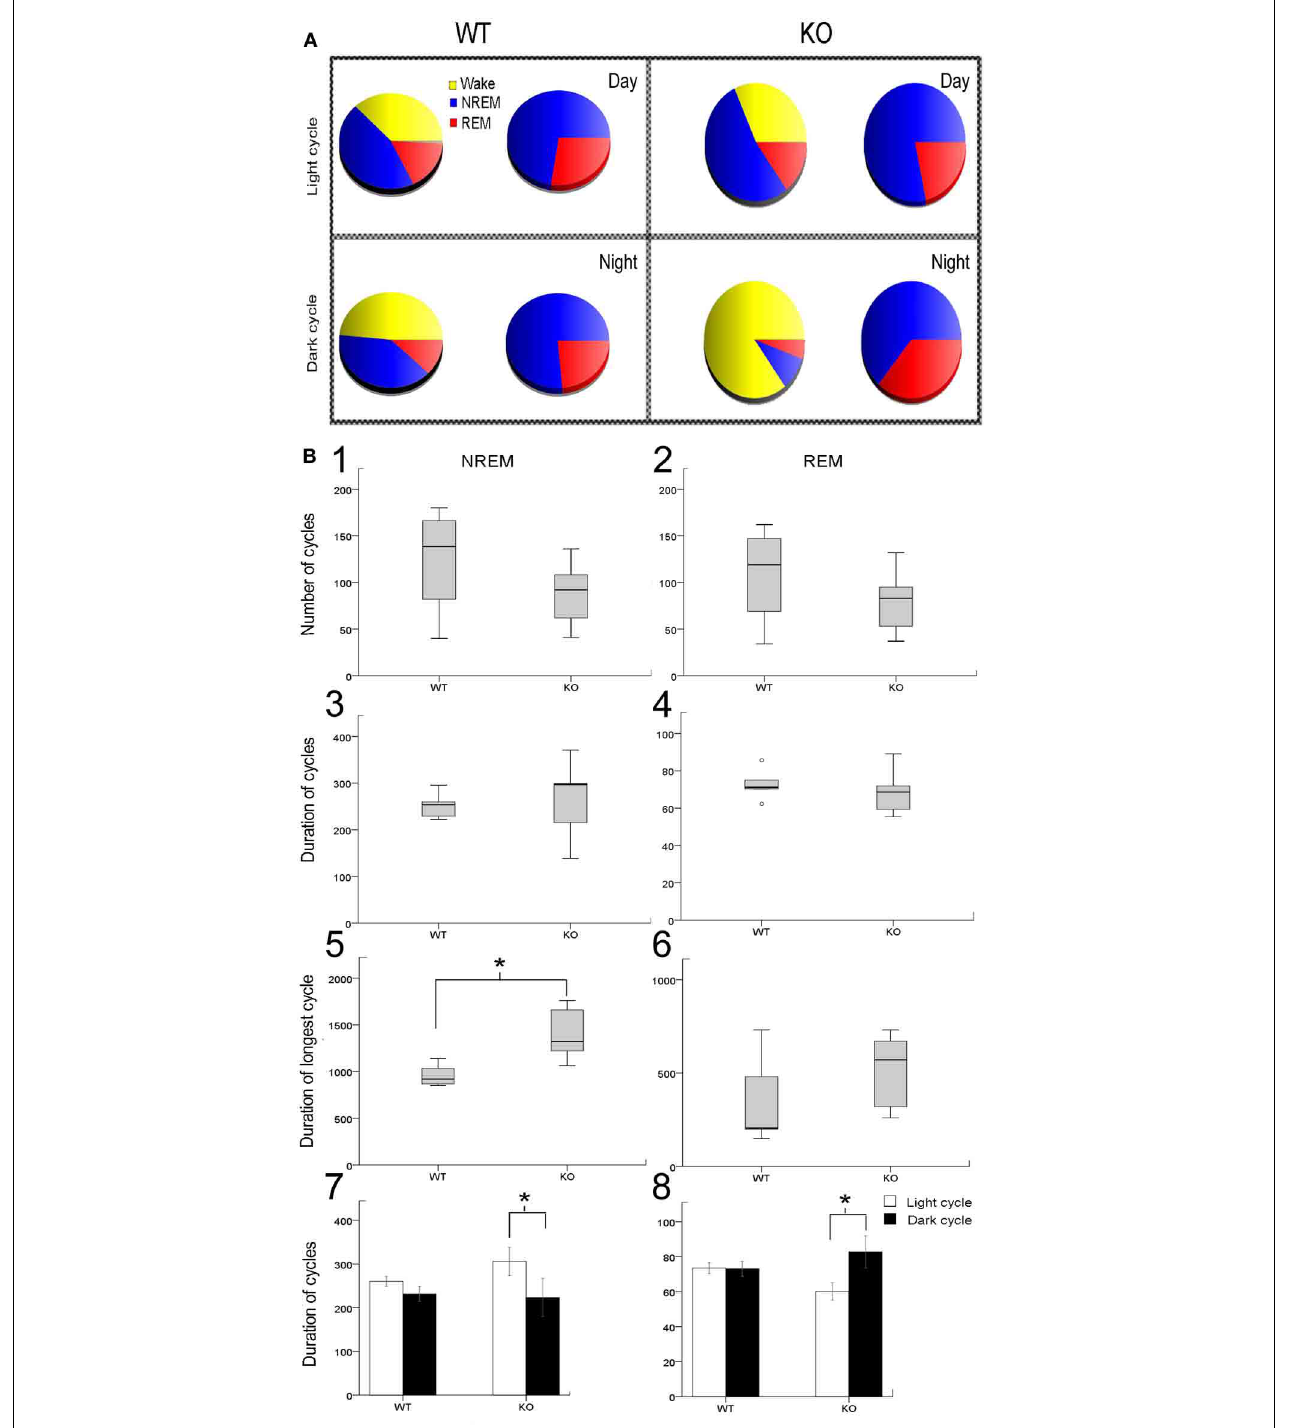
FIGURE 2 | Sleep microstructure—(A) Representative sleep-wake-cycle pie charts represent the diurnal variation in wake/sleep cycle (yellow, red, and blue) changes in WT vs. KO. The pie chart on right (red and blue only) highlights the sleep pie charts related to NREM vs. REM within the 12h activity charts on left. (B) Analysis of sleep microstructure cycles showed fewer NREM and REM cycles as expected due to fewer ultradian sleep